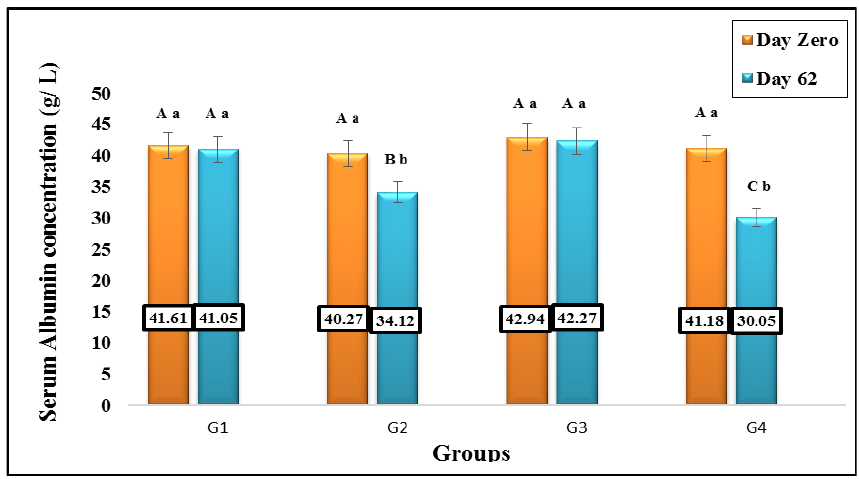
Figure 9. Effect of phosphatidylcholine, fructose and/or combination on serum albumin concentration (g/L). Mean ± SE, n = 9 in a group. G1 control groups (C), G2: (Pc), G3: (Fr), G4: (Fr +